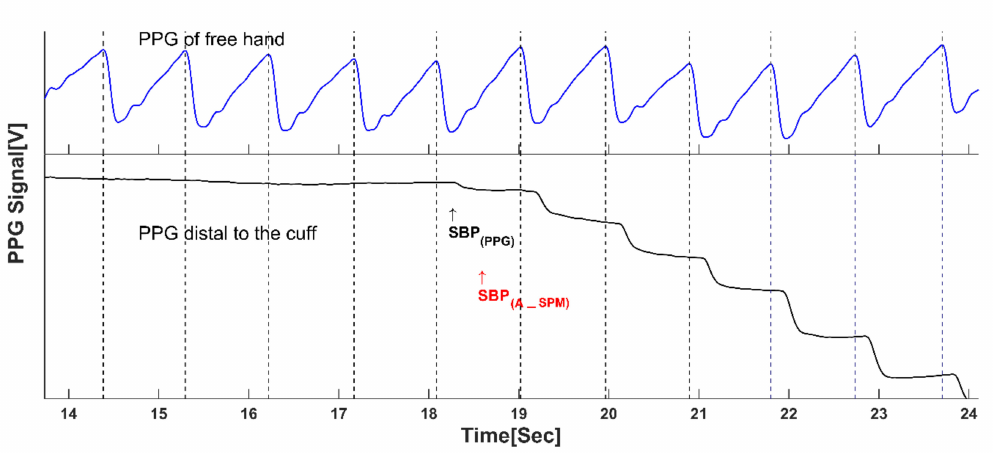
Figure 1. Curves of the PPG in fingers in the two hands at a time interval during cuff deflation, when the cuff-pressure was in the neighbourhood of the SBP value. The blue curve is the PPG signal measured in the cuff-free hand. The black curve is the PPG signal measured in the hand distal to the cuff. When the cuff air-pressure decreases below SBP, the arteries open and the PPG pulses reappear. At the same time, the baseline of the PPG curve starts to decrease because the cuff-pressure is above the venous pressure, and blood flowing through the arteries is accumulated in the veins, thereby reducing the light transmission through the tissue. The start of each PPG pulse in the free hand (at end-diastole/start of systole) is marked by a vertical line, serving as a time-reference for validating that the pulse in the black curve is a PPG pulse. The arrows marked by SBP (PPG) and SBP (KA) designate the time at which the first PPG pulse and the first Korotkoff appear,